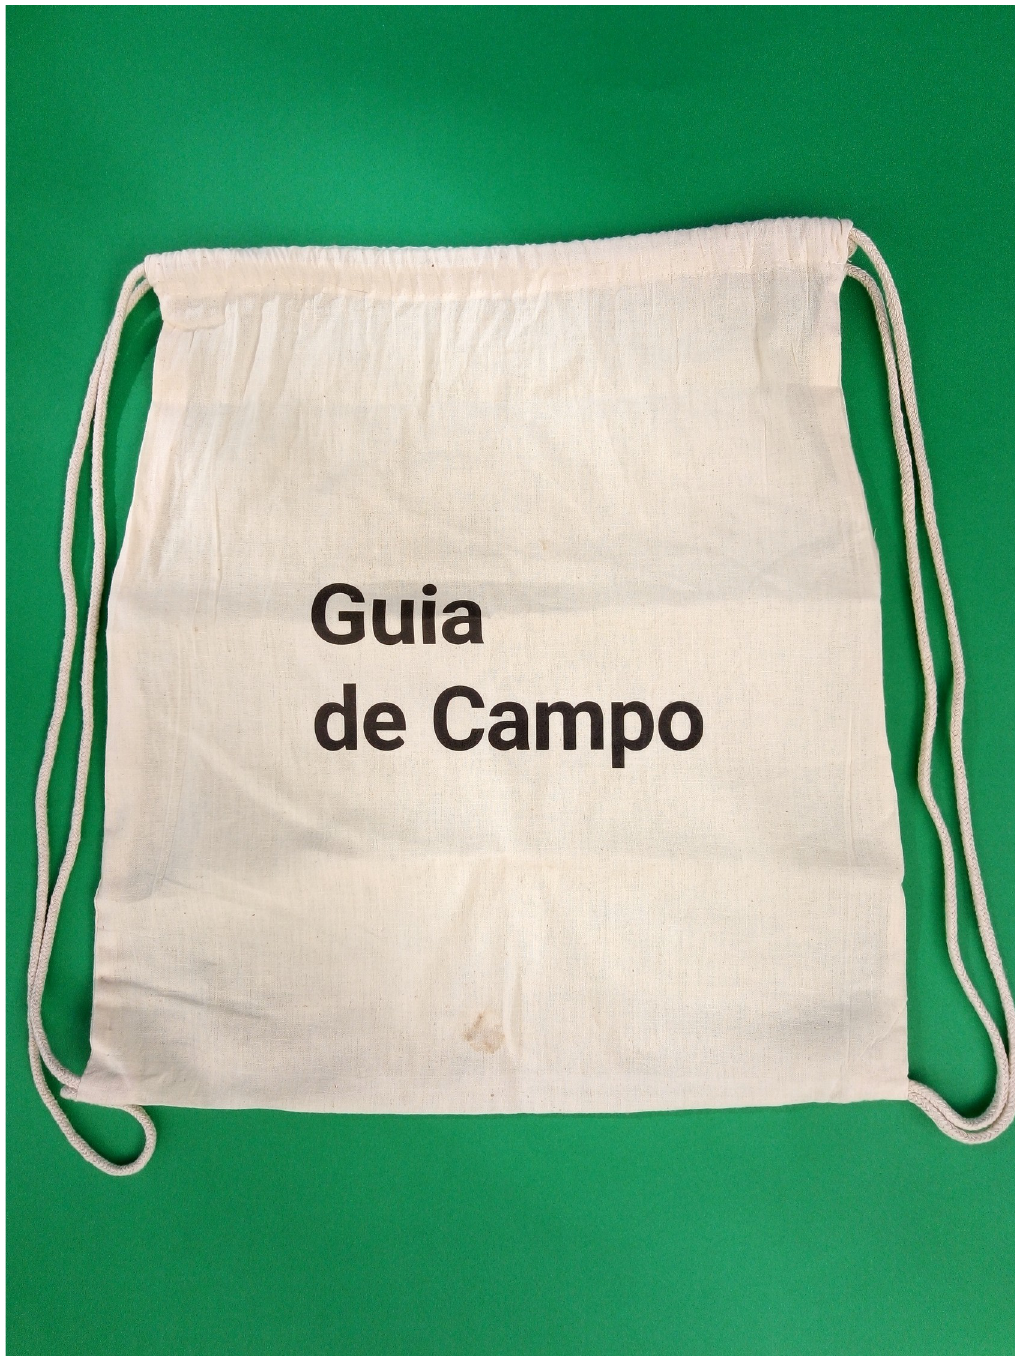
Fig 3. The Field Guide cultural probe toolkit canvas bag (with original project title in